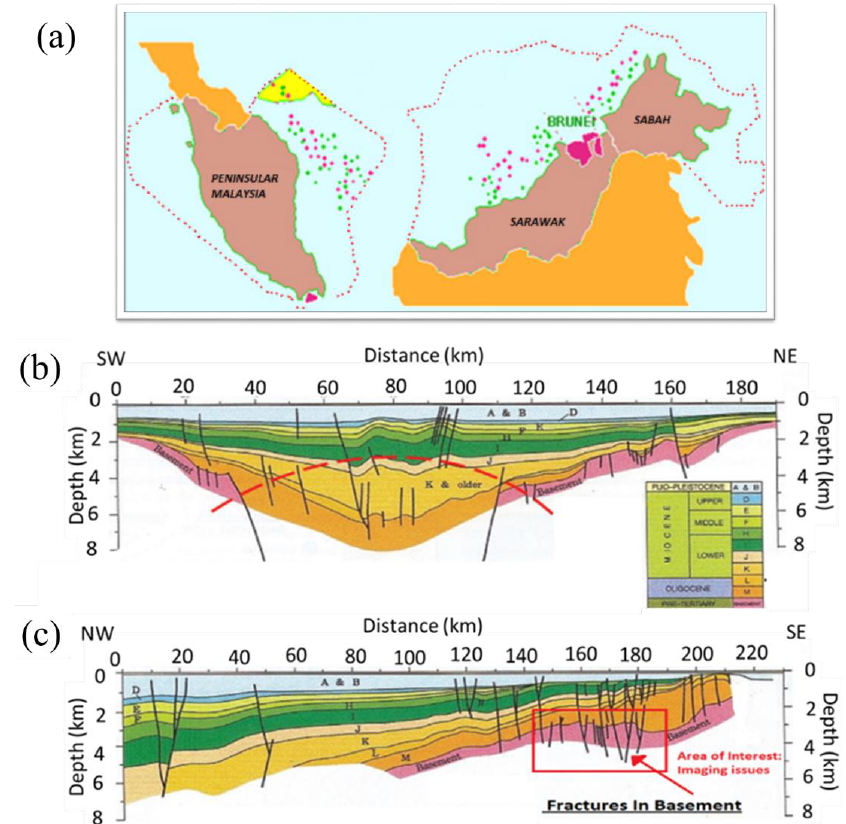
Figure 4. ( a ) Geographical map of the Malay Basin. Shown are the provinces of Peninsular in the Malay Basin, Sarawak, and Sabah Basin [24]. The Malay Basin subsurface structure shown with a regional cross-section view. ( b ) South-west to north-south section. The fractured basement can be seen at a depth of 2–5 km and varies with lateral extension. ( c ) North-west to south-east section